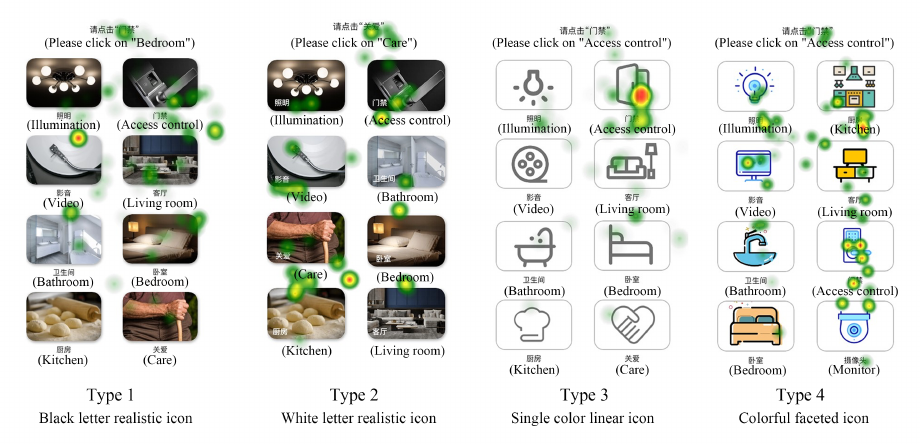
Figure 6. Gaze data heat map of 4 styles of button